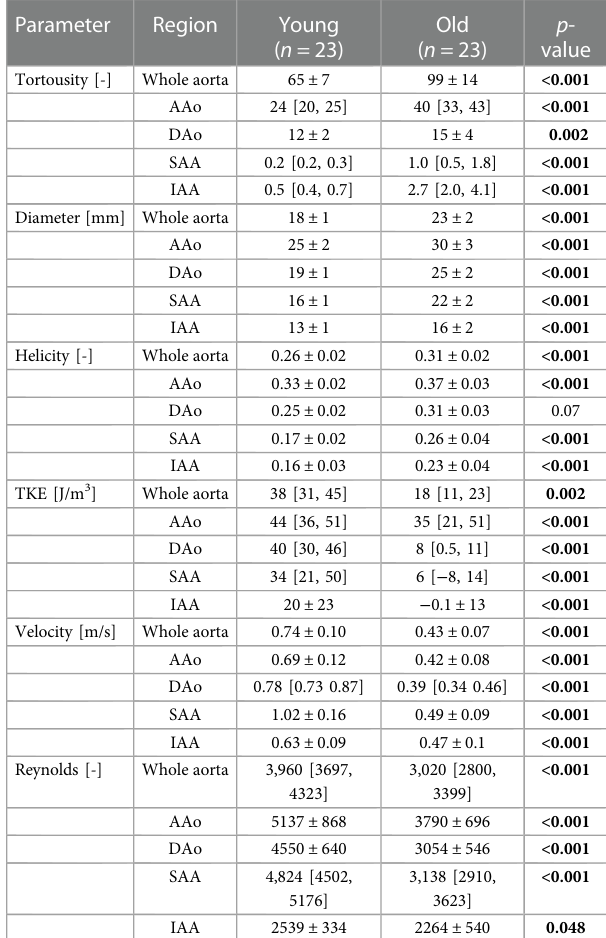
TABLE 3 List of correlations amongst studied